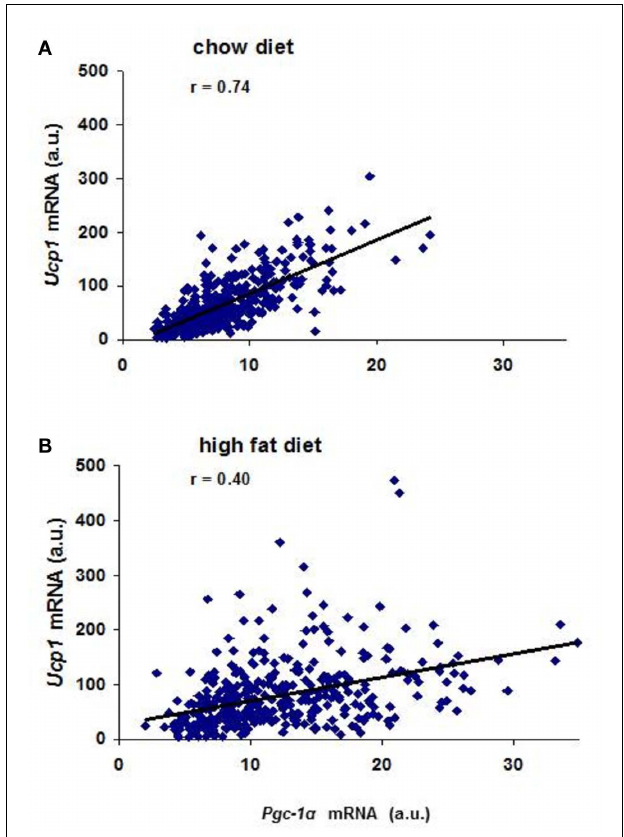
FIGURE 4 | (A) Correlation between Pgc- 1 α and Ucp 1 mRNA levels in mice fed a 4.5 wt% fat diet. Approximately 400 (B6 × A/J) F1 × A/J backcross males 8weeks of age were exposed to 5˚C for 7days. (B) Correlation between Pgc- 1 α and Ucp 1 mRNA levels in mice fed a 58-kcal% fat diet. Pgc- 1 α and Ucp 1 mRNA levels were determined in 400 backcross animals maintained on a high fat diet from weaning to 8weeks of age and then exposed to the cold for 7days.